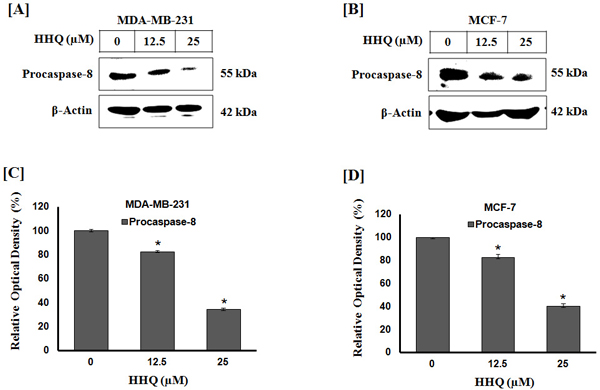
Expression analyses of proenzyme caspase-8 in response to HHQ treatment in human breast cancer cells (MDA-MB-231 and MCF-7). The breast cancer cells were treated with 12.5 μM and 25 μM of HHQ for 48 h at 37 °C. Representative western blot hybridization signals for proenzyme caspase-8 for MDA-MB-231 [A] and MCF-7 [B] and the quantitation of the signals are shown in [C] and [D], respectively. Significant decrease in expression of proenzyme caspase-8 was observed in HHQ treated cells. Data are presented as mean ± SEM of three independent experiments. *p< 0.005 represents statistically difference between control and HHQ test groups.